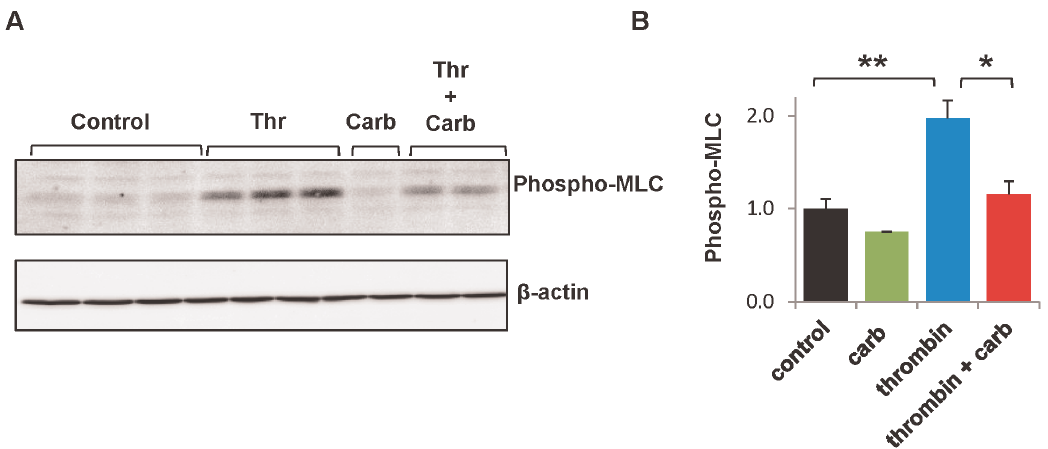
Figure 7. Gap junction inhibitor carbenoxolone attenuates thrombin-induced MLC phosphorylation. HPAECs were treated with carbenoxolone for . 5 min followed by thrombin treatment (0.5 U/mL; 30 min) and collected for Western Blot. A.) Representative Western Blot is shown. B.) Phospho-MLC protein was normalized to b -actin relative to control. **, p , 0.001. *, p , 0.05. n=5 for control (C), thrombin alone (thr), and thrombin + carbenoxolone (thr + carb) groups. n=1 for carbenoxolone (carb).